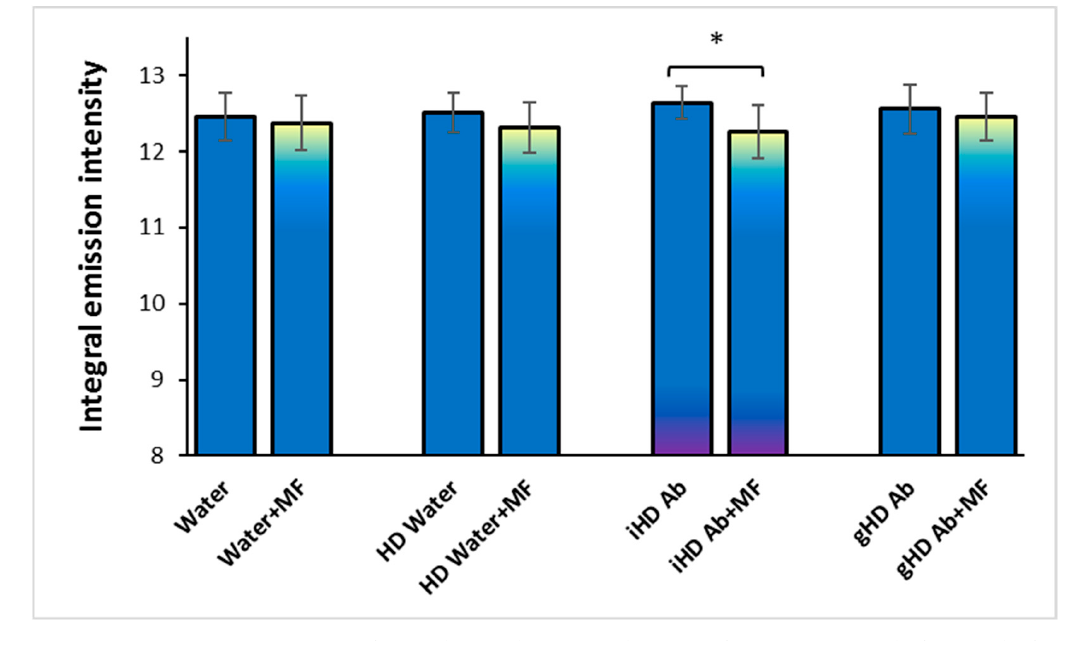
Figure 3. Emission intensities of samples in the spectral range of 470–2000 cm − 1 before and after exposure to a magnetic field. ‘+MF’ indicates that the solution has been exposed to a magnetic field. Data are presented as mean ± SD. *—statistically significant difference in the integral emission intensity of the sample after the action of the magnetic field and the corresponding sample before the action of the magnetic field ( p < 0.05, Welch test with the Holm correction).